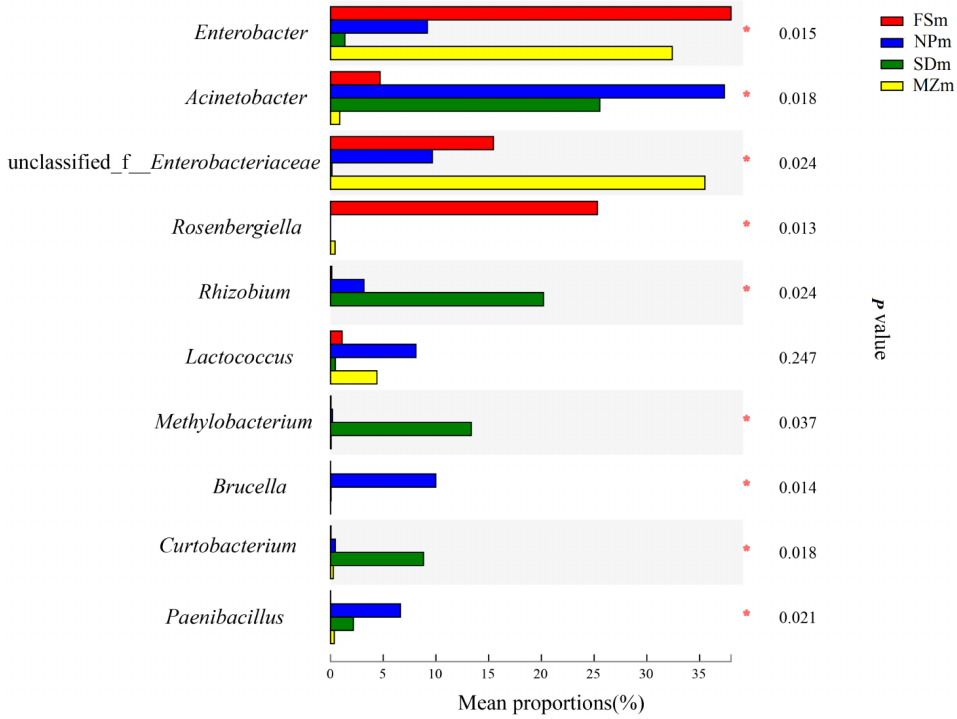
Figure 4. One-way analysis of variance bar plots of the genus level (10 most abundant genera) among different forage epiphytic microbiota groups. *, 0.01 < p < 0.05. FSm, forage sorghum microbiota; NPm, Napier grass microbiota; SDm, Sudan grass microbiota; MZm, maize